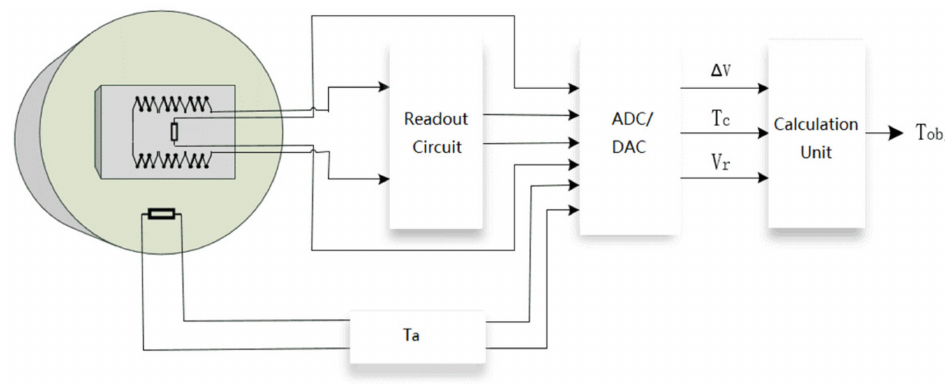
Figure 5. Self-test model of infrared thermopile